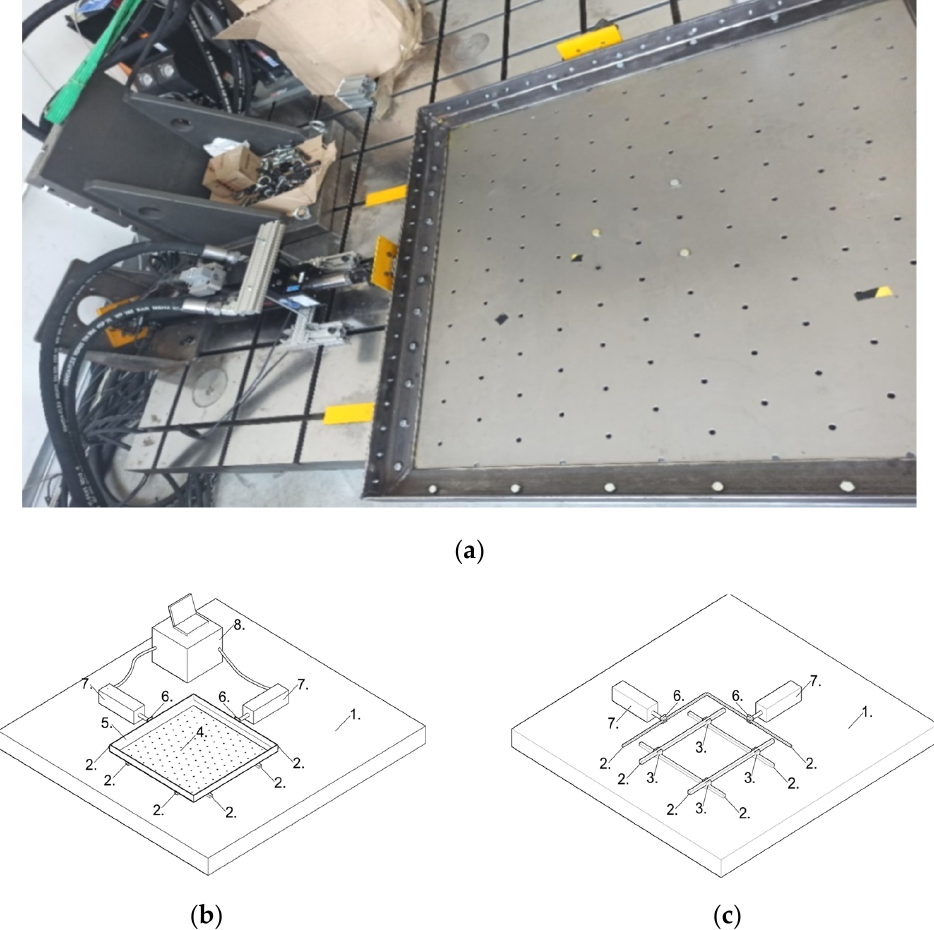
Figure 6. ( a ) The general view of the shaking table; ( b ) the scheme of the table; ( c ) the scheme of the support (1—the steel foundation; 2—the linear guides; 3—the carriages; 4—the operating